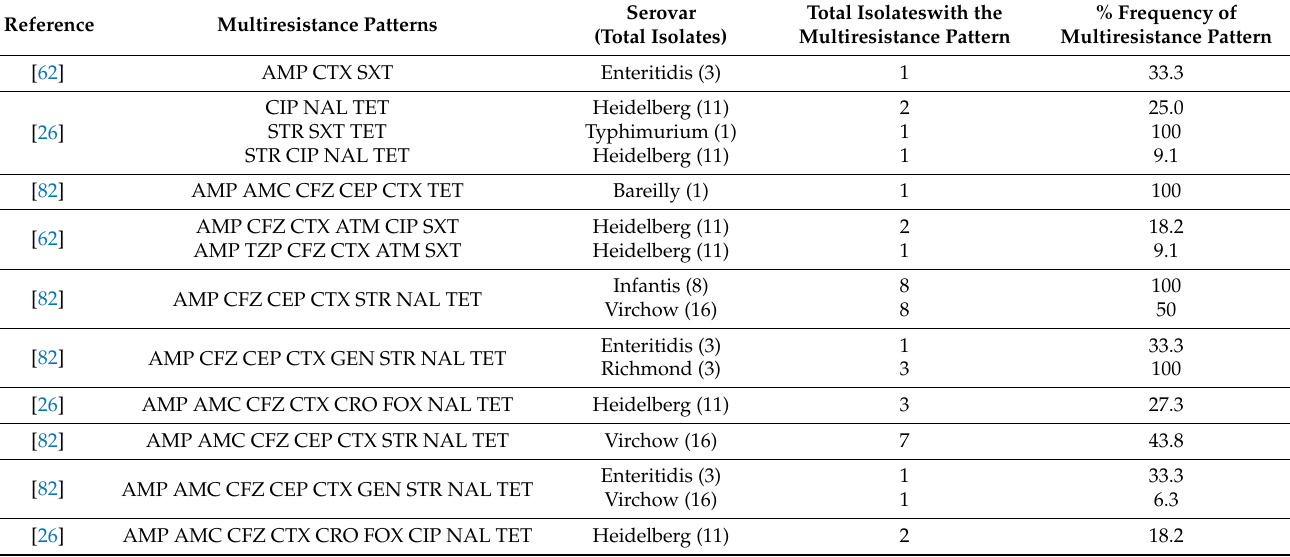
Table 6. Salmonella serovar patterns of multidrug resistance as determined by disc diffusion and MIC.